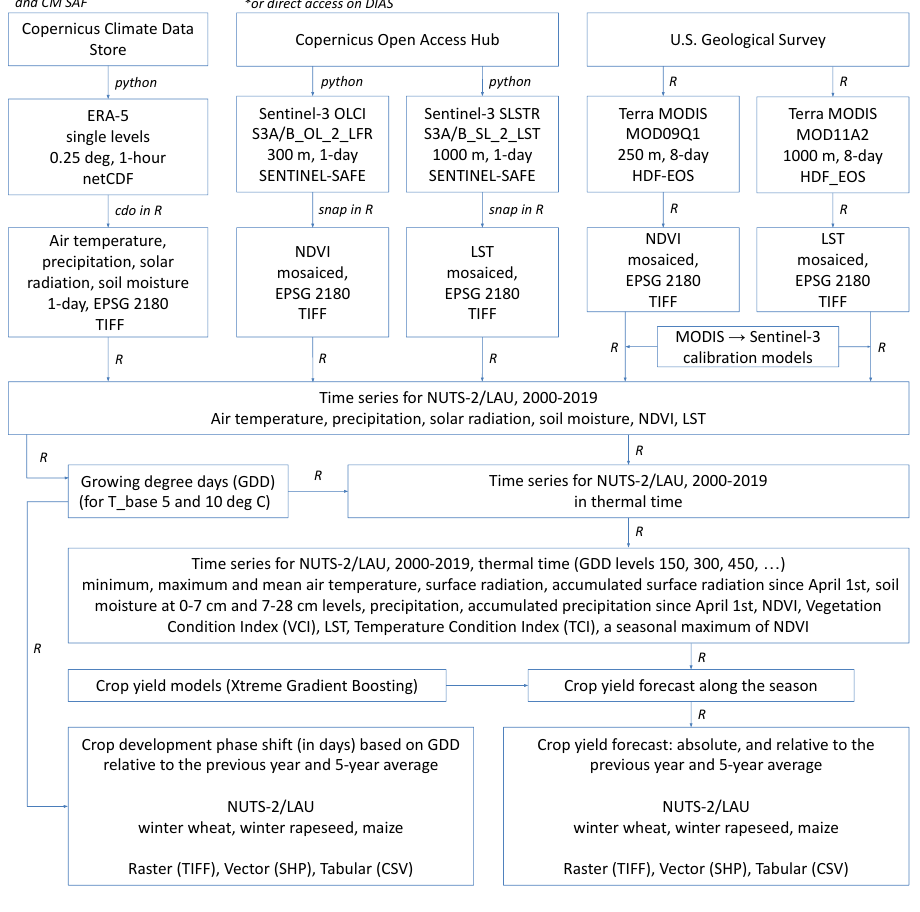
Figure 16. Workflow of the crop yield forecasting system, data streams, and software used (‘cdo’— Climate Data Operators v1.9.9 , R v4.1.1, Python